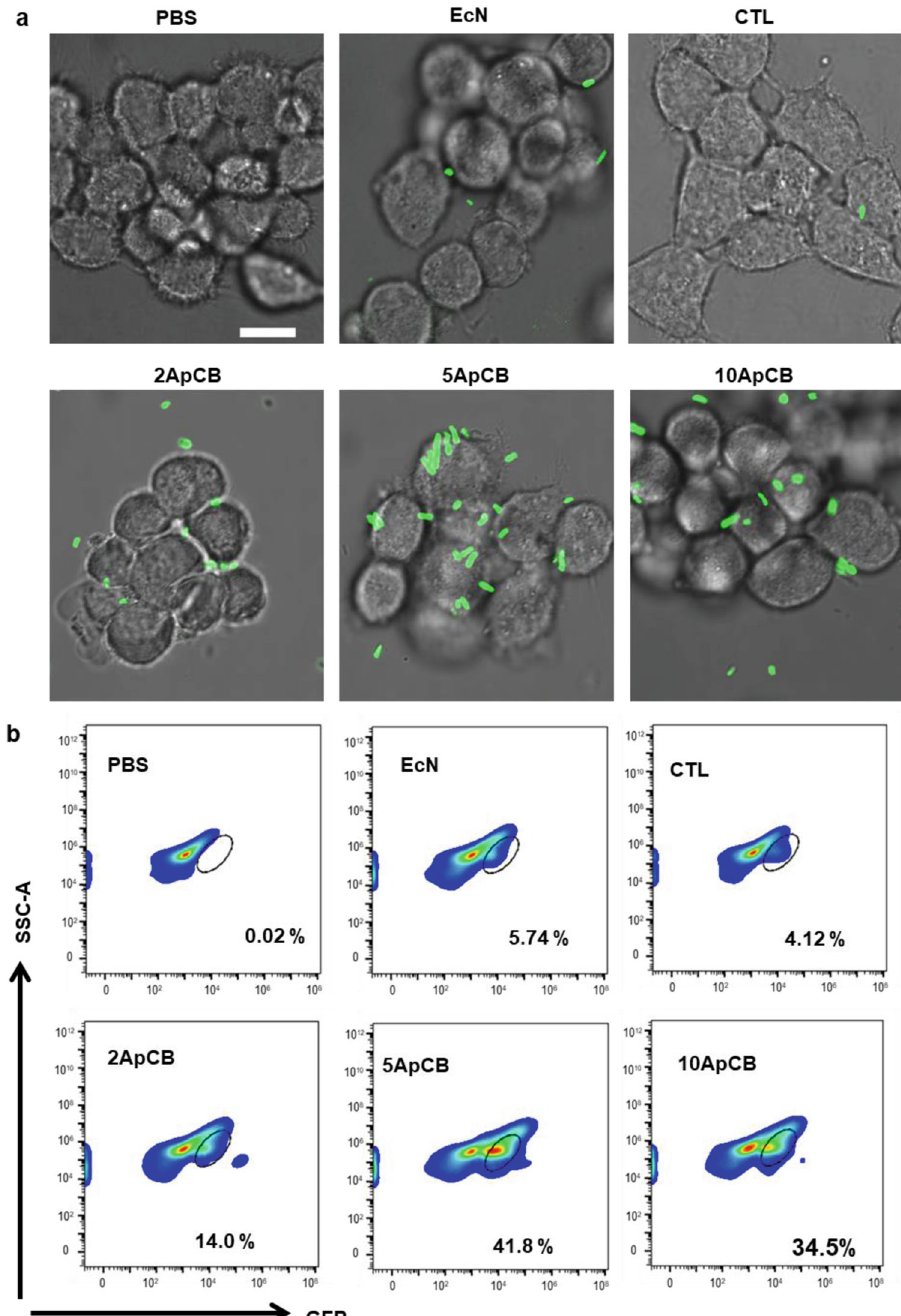
Fig. 2 Binding of ApCB with 4T1 cells. a Representative LSCM images of 4T1 cells after incubation with PBS, EcN GFP , CTL GFP , 2ApCB GFP , 5ApCB GFP , and 10ApCB GFP at 37 °C for 2 h, respectively. Cells were rinsed with PBS before observation. Green channel means EcN producing GFP. Images are representative of three independent biological samples. Scale bar: 10 µ m. b Flow cytometric analysis of the co-incubated 4T1 cells. Flow plots are representative of three independent biological samples. Source data are provided as a Source Data fi